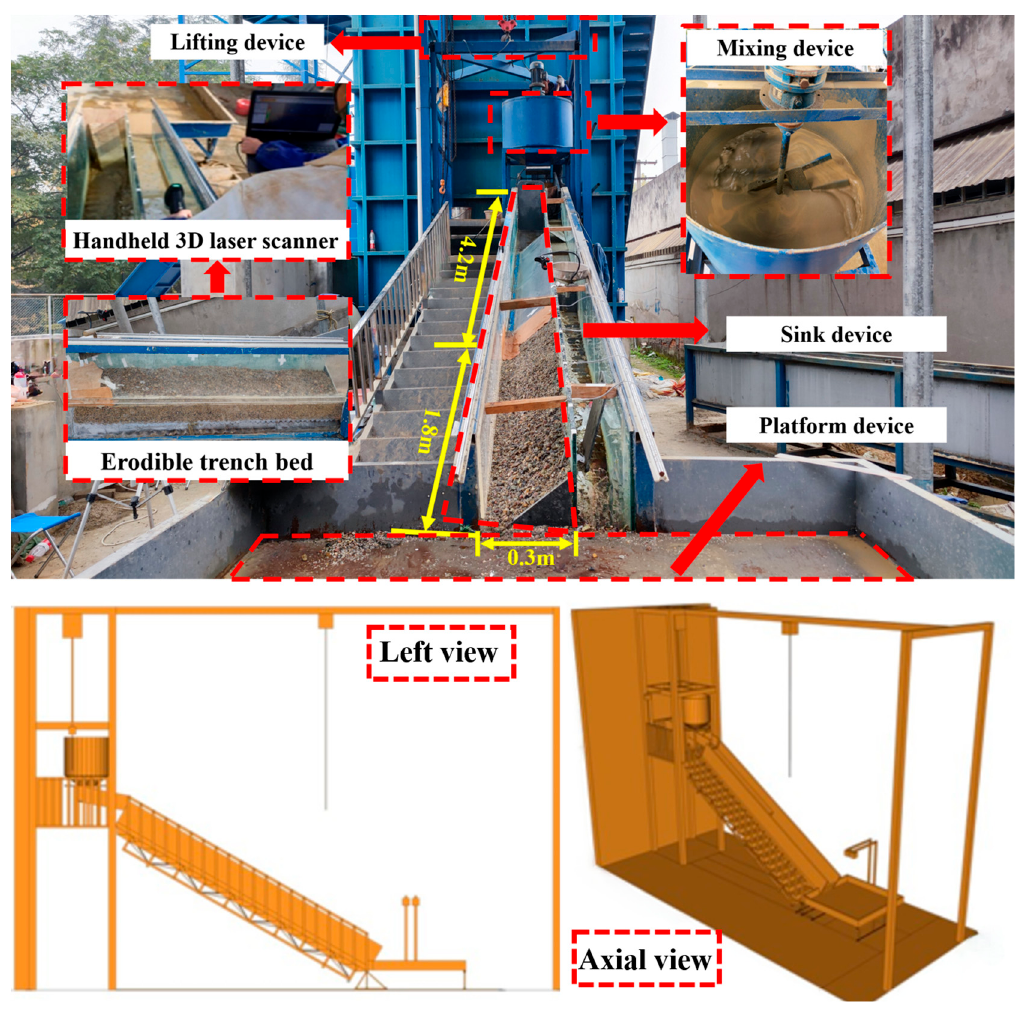
Figure 1. Experimental